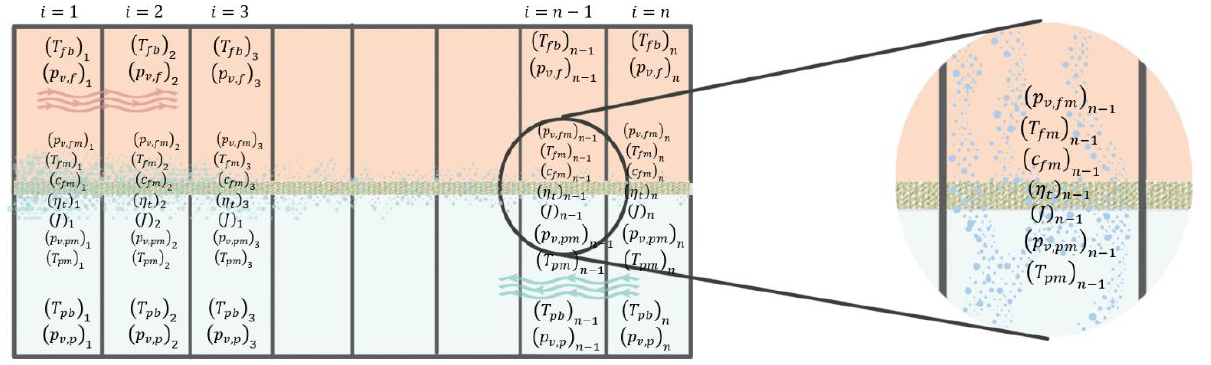
’ represent the v